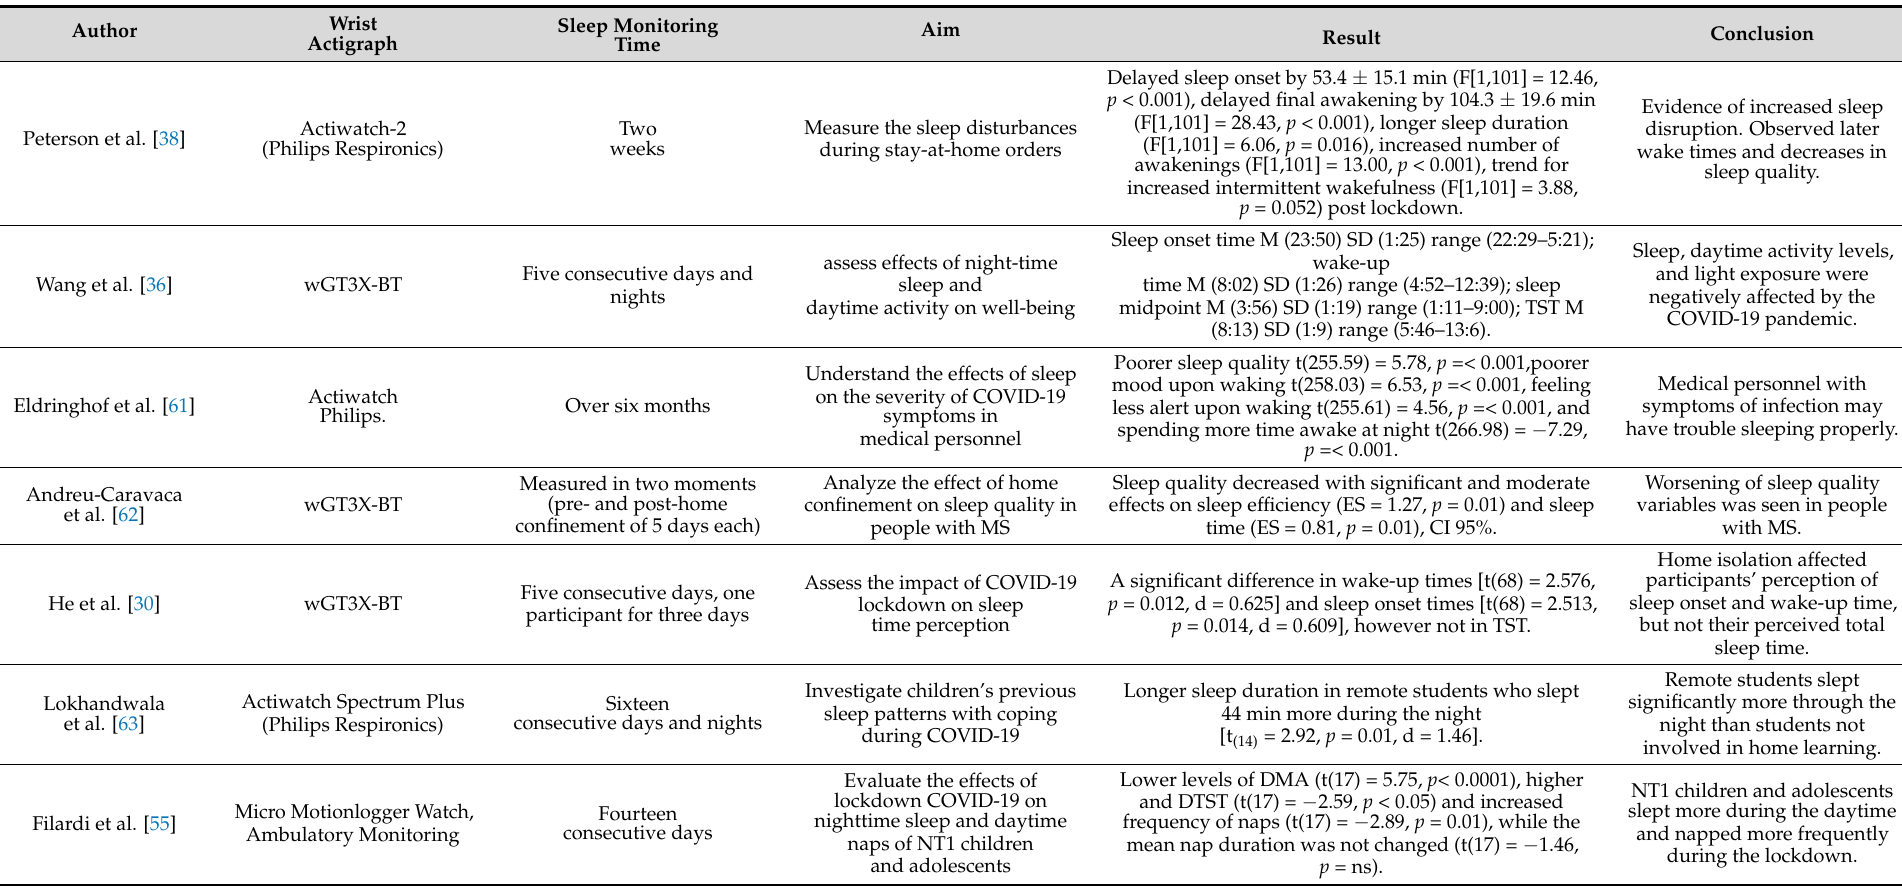
Table 2. Description of the selected studies and the sleep evaluation by